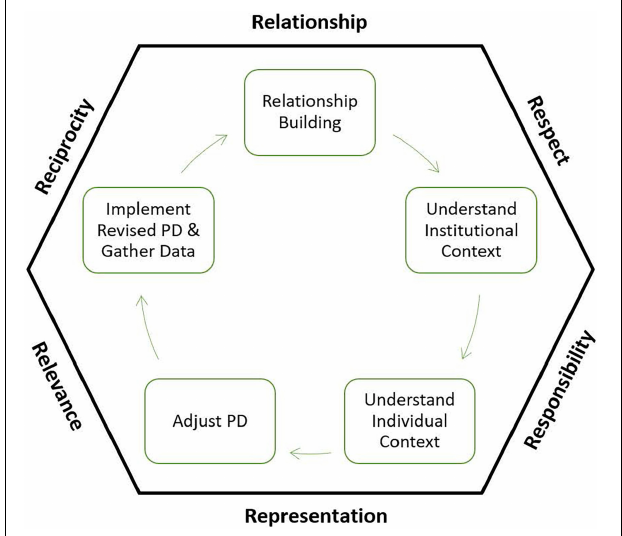
FIGURE 2 | Five key elements of